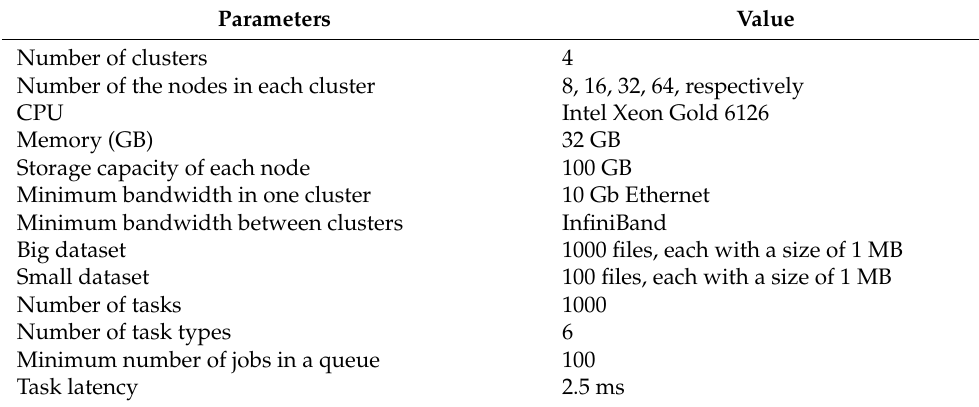
Table 3. Experimental parameter configuration.